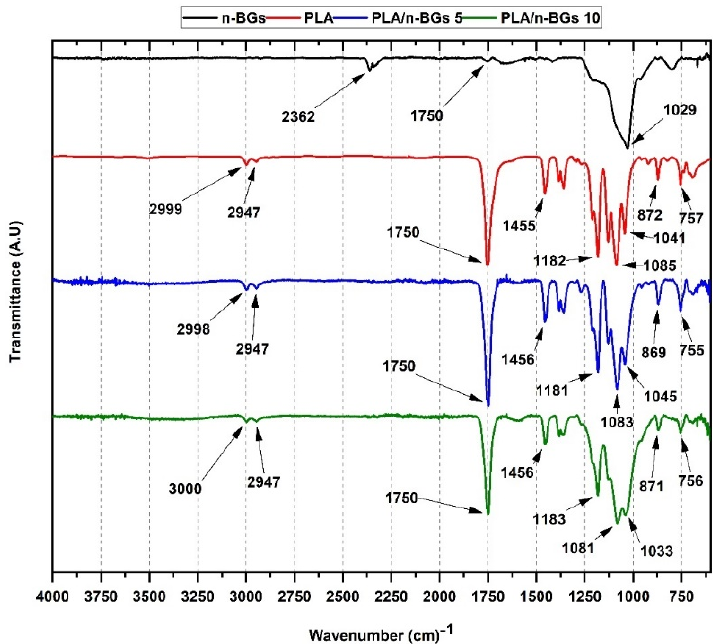
Figure 5. FT-IR of neat PLA and PLA/n-BGs nanocomposites of 5 wt.% and 10 wt.%.